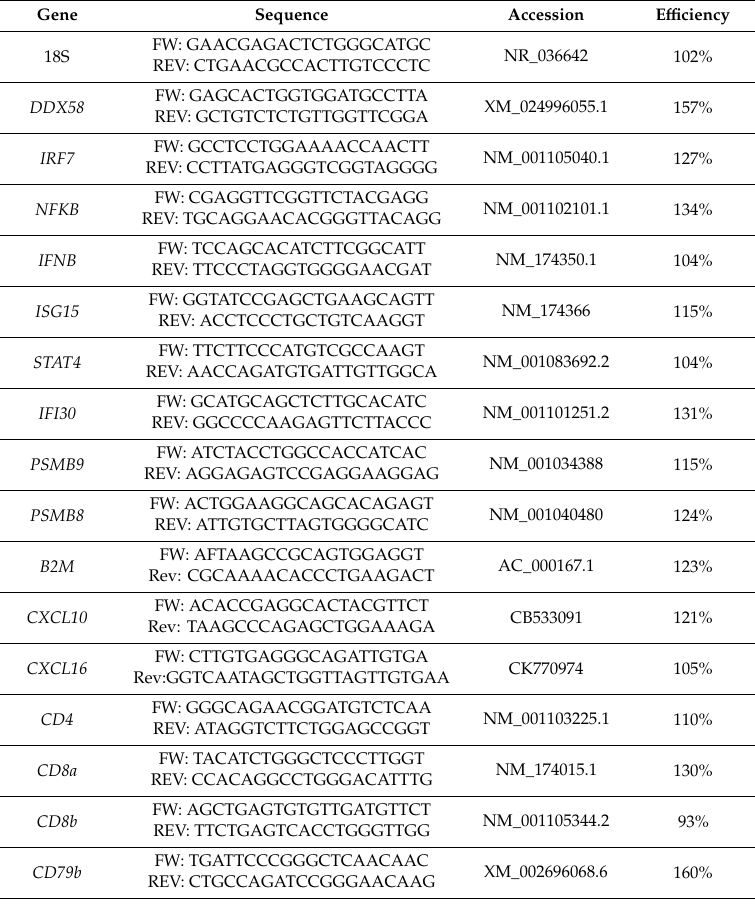
Table 1. Primers utilized for